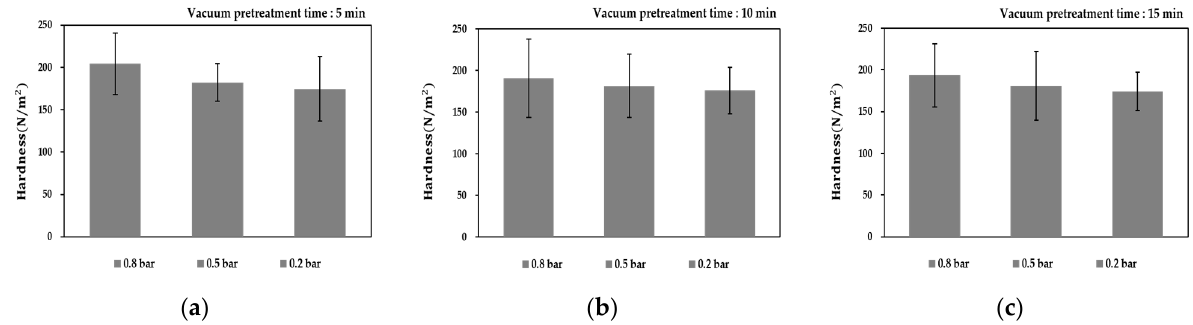
Figure 7. Change in hardness of solid particles under different OH–VC combination heating conditions with agitation: vacuum pretreatment time for ( a ) 5 min, ( b ) 10 min, and ( c ) 15 min at different vacuum intensity levels.